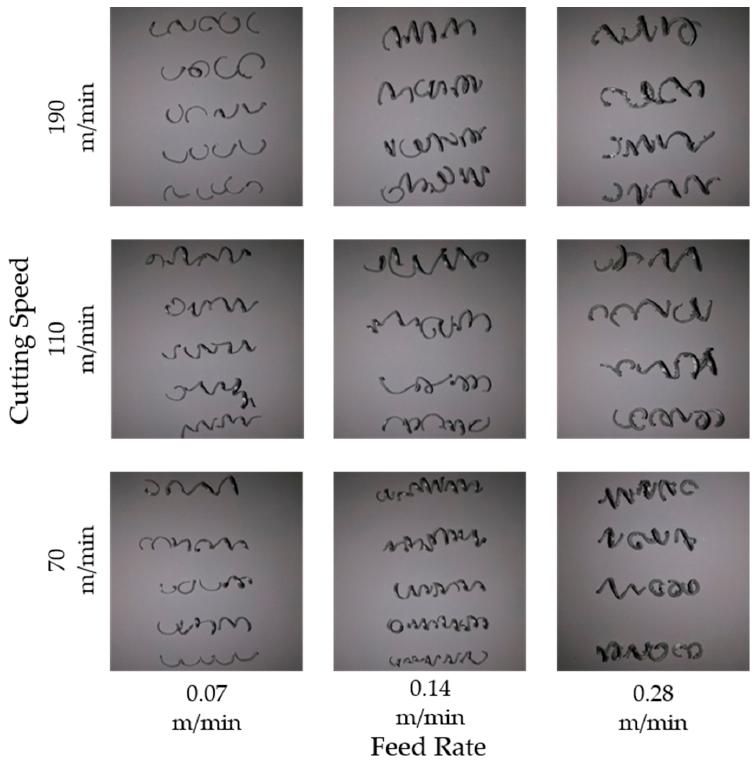
Figure 10. Chip length variations with various feed rates and cutting speed at a constant cut depth of 0.9 mm .